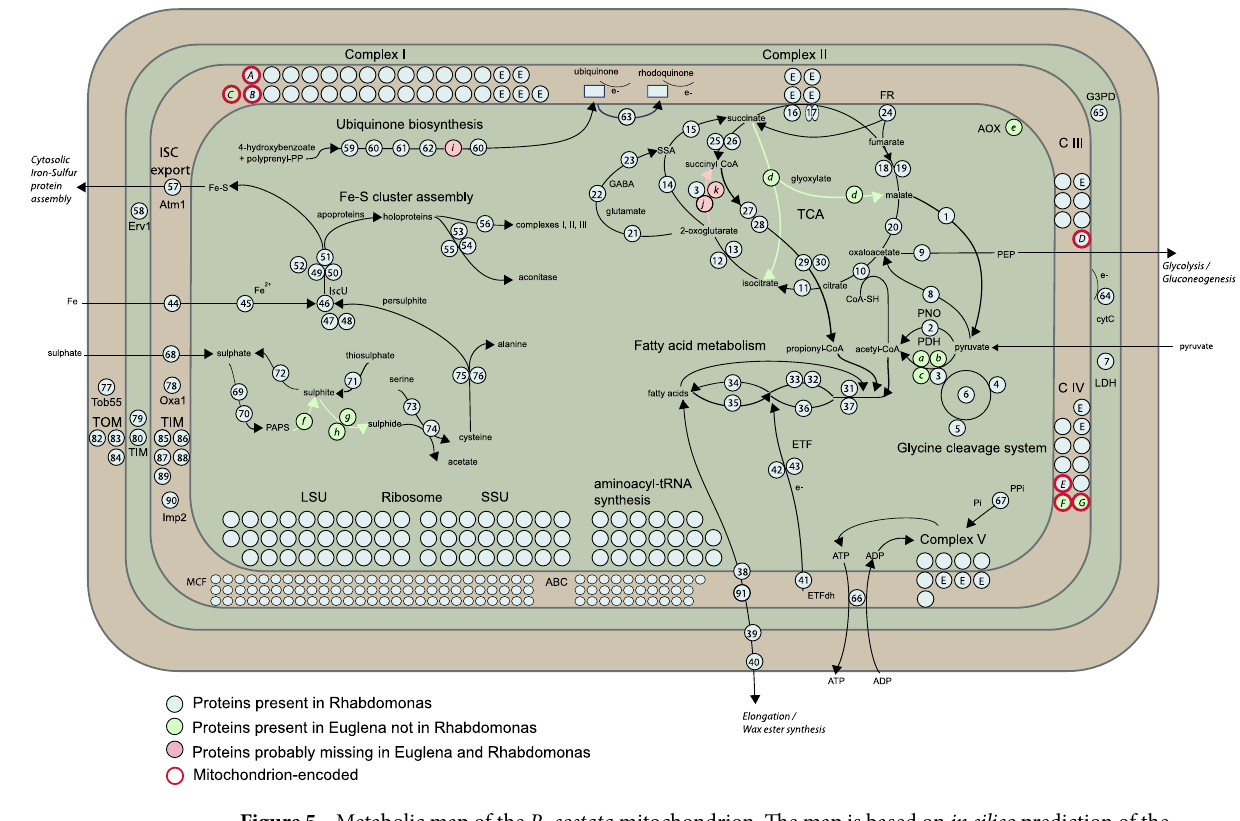
Figure 5. Metabolic map of the R. costata mitochondrion. The map is based on in silico prediction of the mitochondrial proteome from the transcriptomic dataset. Blue circles represent enzymes present in R. costata with homologues in E. gracilis , light green circles represent enzymes absent in R. costata but present in E. gracilis, and pink circles represent typical eukaryotic enzymes missing in both euglenids. The figure allows for comparison, inspired by Ebenezer et al. 2019. Abr.: E in complexes—Euglenozoa specific subunits, Lowercase letters—enzyme absent in R. costata mitochondrion: a/ pyruvate dehydrogenase E1 component alpha subunit, b/ pyruvate dehydrogenase E1 component beta subunit, c/pyruvate dehydrogenase E2 component, d/ bifunctional glyoxylate cycle enzyme malate synthase/isocitrate lyase, e/ alternative oxidase, f/ phosphoadenosine phosphosulphate reductase, g/ sulphite reductase (NADPH) flavoprotein alpha-component, h/ sulphite reductase (NADPH) hemoprotein beta-component, i / 3-demethoxyubiquinol 3-hydroxylase, j/ 2-oxoglutarate dehydrogenase E1 component, k/ 2-oxoglutarate dehydrogenase E2 component. Capital letters—mitochondrial encoded enzymes: A/ cytochrome c oxidase subunit 1, B/ cytochrome c oxidase subunit 2, C/ cytochrome c oxidase subunit 3, D/ cytochrome b, E/ NADH dehydrogenase subunit 4, F/ NADH dehydrogenase subunit 1, G/ NADH dehydrogenase subunit 5. The numbers correspond to the designations in Supplementary Table S8 online and the main